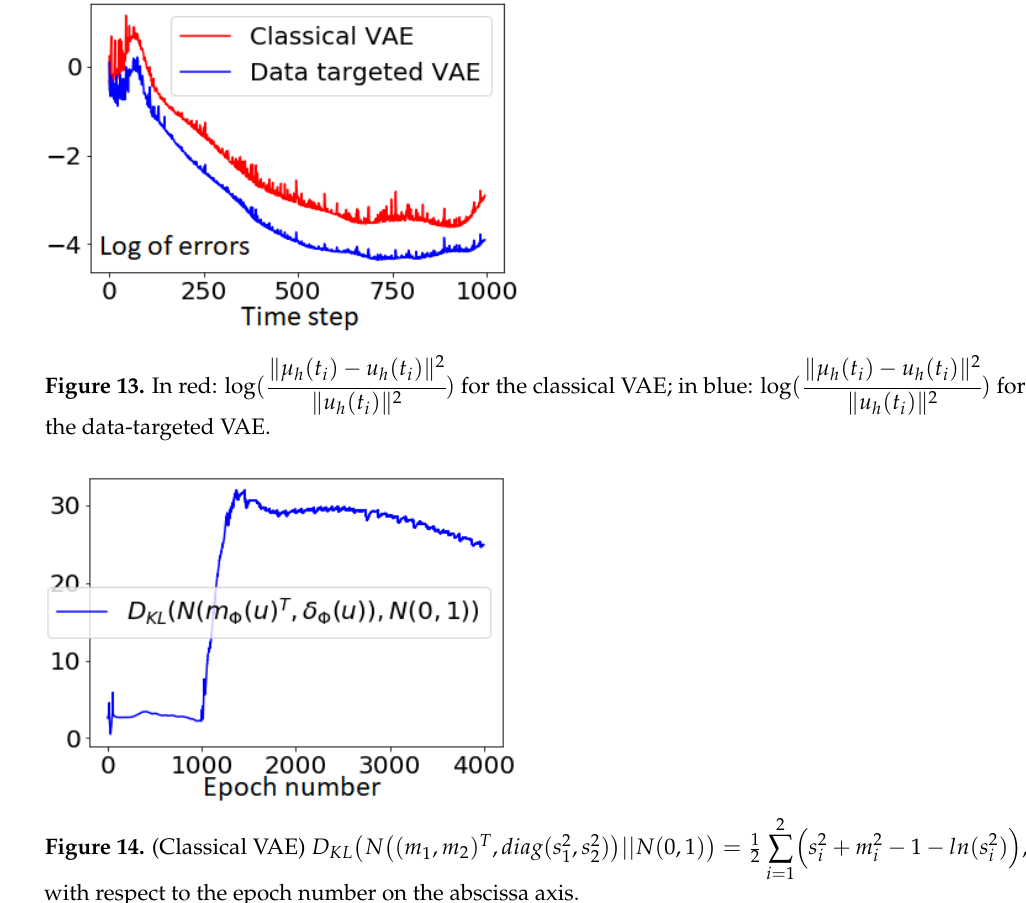
Figure 14. (Classical VAE) D KL with respect to the epoch number on the abscissa